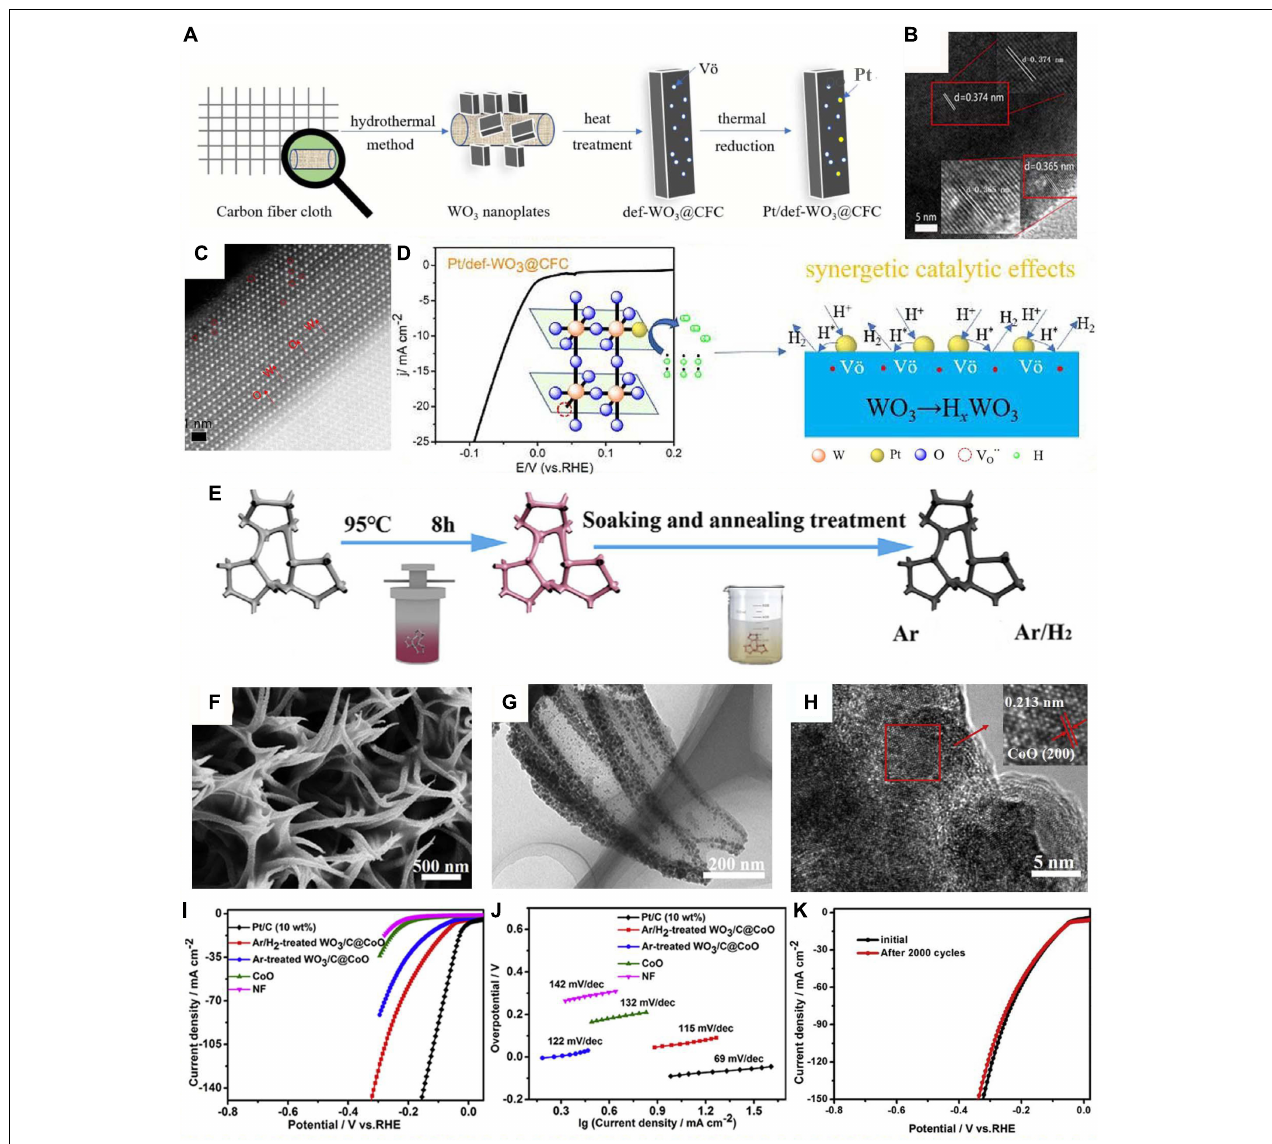
FIGURE 2 | (A) Scheme diagram for the synthetic process of Pt/def-WO 3 @CFC. (B) High-resolution transmission electron microscope (HRTEM) of WO 3 NPs. (C) Spherical aberration-corrected image of Pt/def-WO 3 @CFC at atomic scale. (D) Linear sweep voltammetry (LSV) curves in 0.5 M H 2 SO 4 at a scan rate of 1 mV/s and the schematic model for Pt/WO 3 nanostructure with O vacancies. Reprinted with permission from Tian et al. (2019). Copyright 2019, The Royal Society of Chemistry. (E) Scheme diagram of the formation of WO 3 /C@CoO/NF. (F) Scanning electron microscope (SEM), (G) TEM, and (H) HRTEM images of Ar/H 2 -treated WO 3 /C@CoO/NF. (I) The LSV curves and (J) the Tafel slopes of different samples. (K) The LSV curves of Ar/H 2 -treated WO 3 /C@CoO/NF before and after 2,000 cycles. Reprinted with permission from Lv et al. (2018a). Copyright 2018,